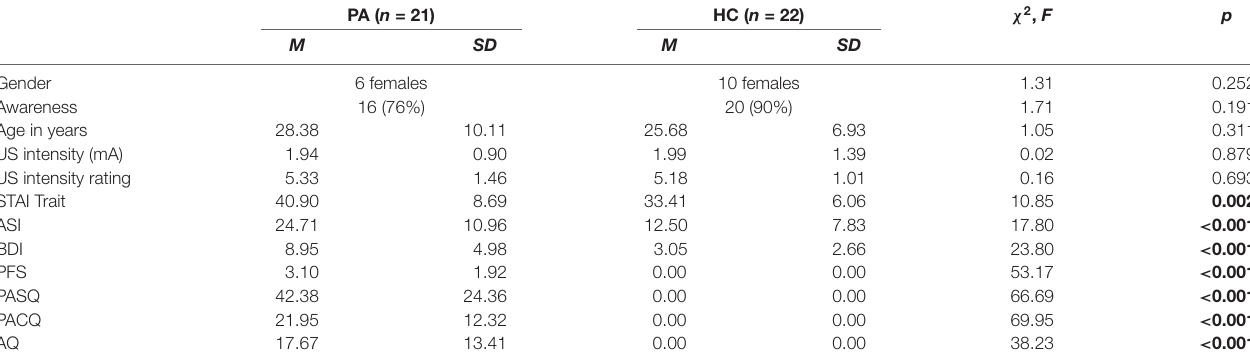
TABLE 1 | Demographic and psychometric data of participants with panic attacks (PA) and healthy controls (HC).